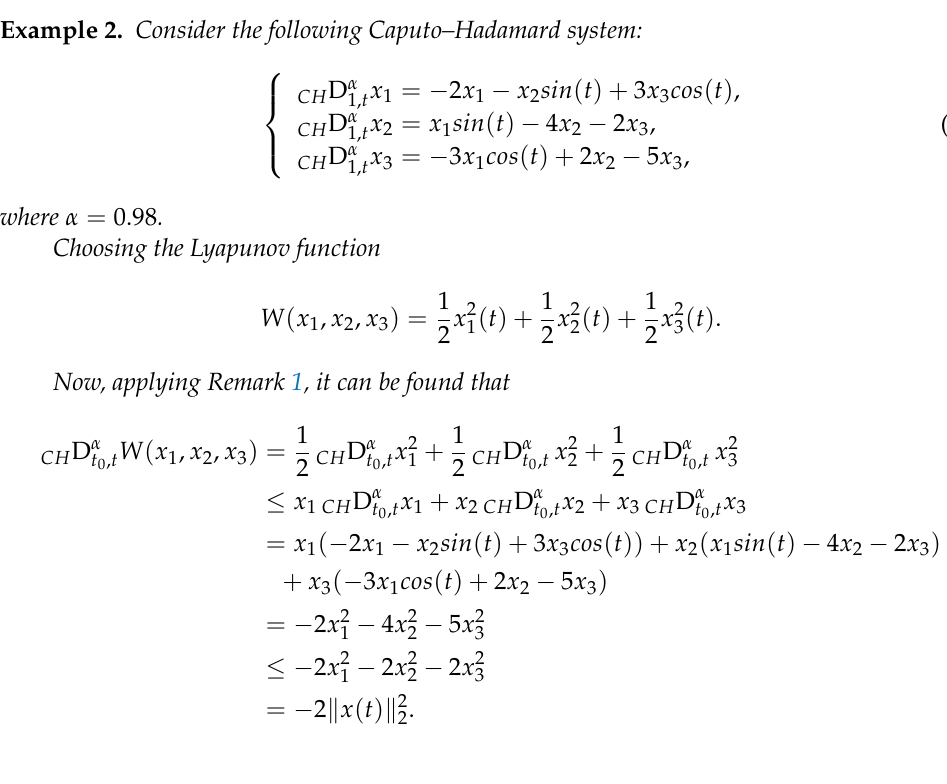
Figure 1. The evolution of system (76) with x ( 1 ) =